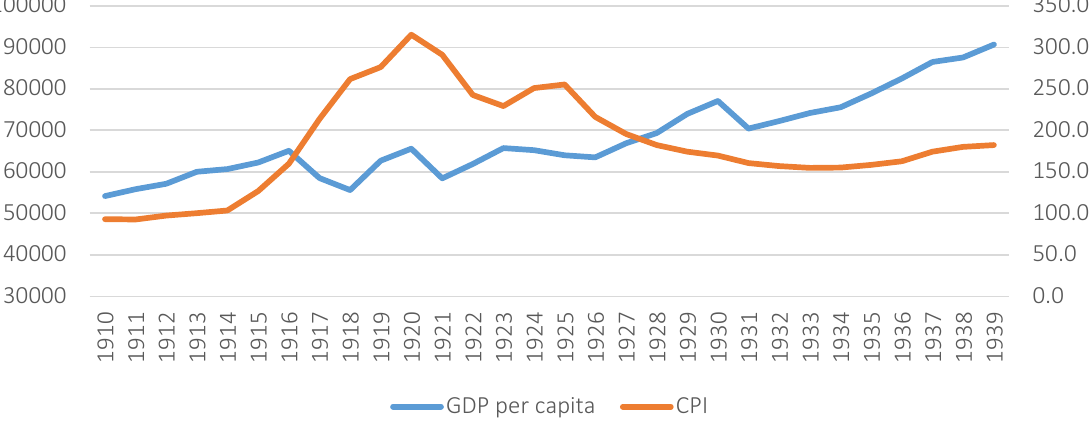
Figure 3. GDP per capita in 2015 USD (left scale) and consumer price index (CPI), 1913 = 100 (right